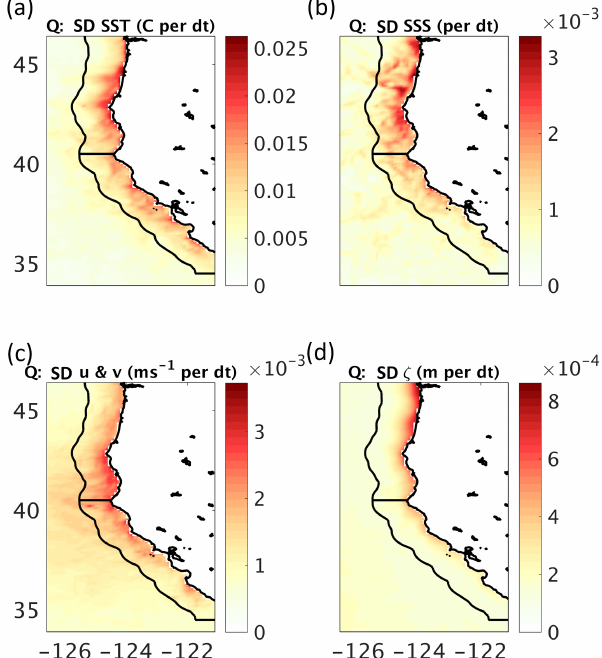
Figure 4. The standard deviation derived from ˆ Q (computed using unsmoothed δ x ) associated with the surface fields of (a) tempera- ture (C per d t ), (b) salinity (per d t ), (c) current speed (ms − 1 per d t ), and (d) sea surface height (m per d t ). The black lines delineate a central and northern CCS region used to compute several diagnos- tics in Sect.